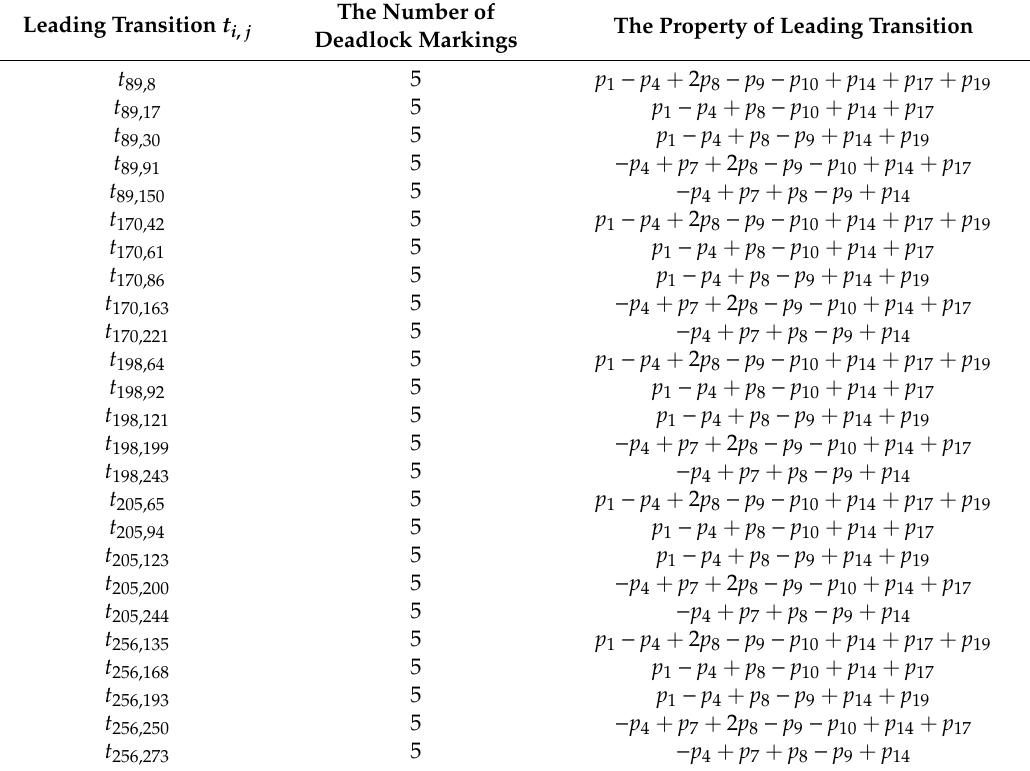
Table 7. The detailed information of all leading transition of Example 2 in second iteration. The Number of Leading Transition t i , j The Property of Leading Transition Deadlock Markings t